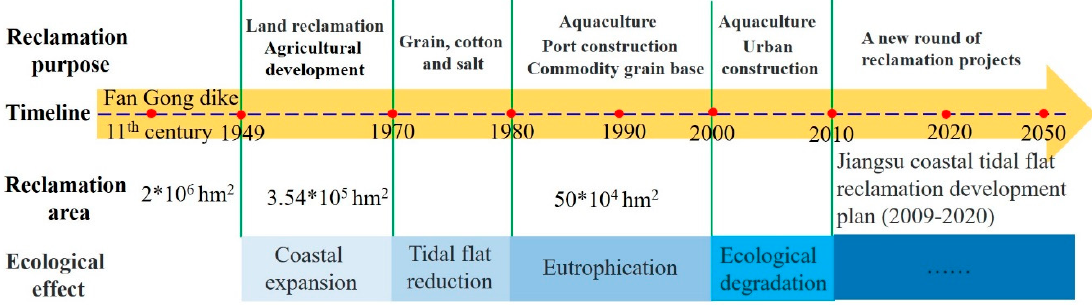
Figure 10. Reclamation history of the tidal flats in the Jiangsu Province.